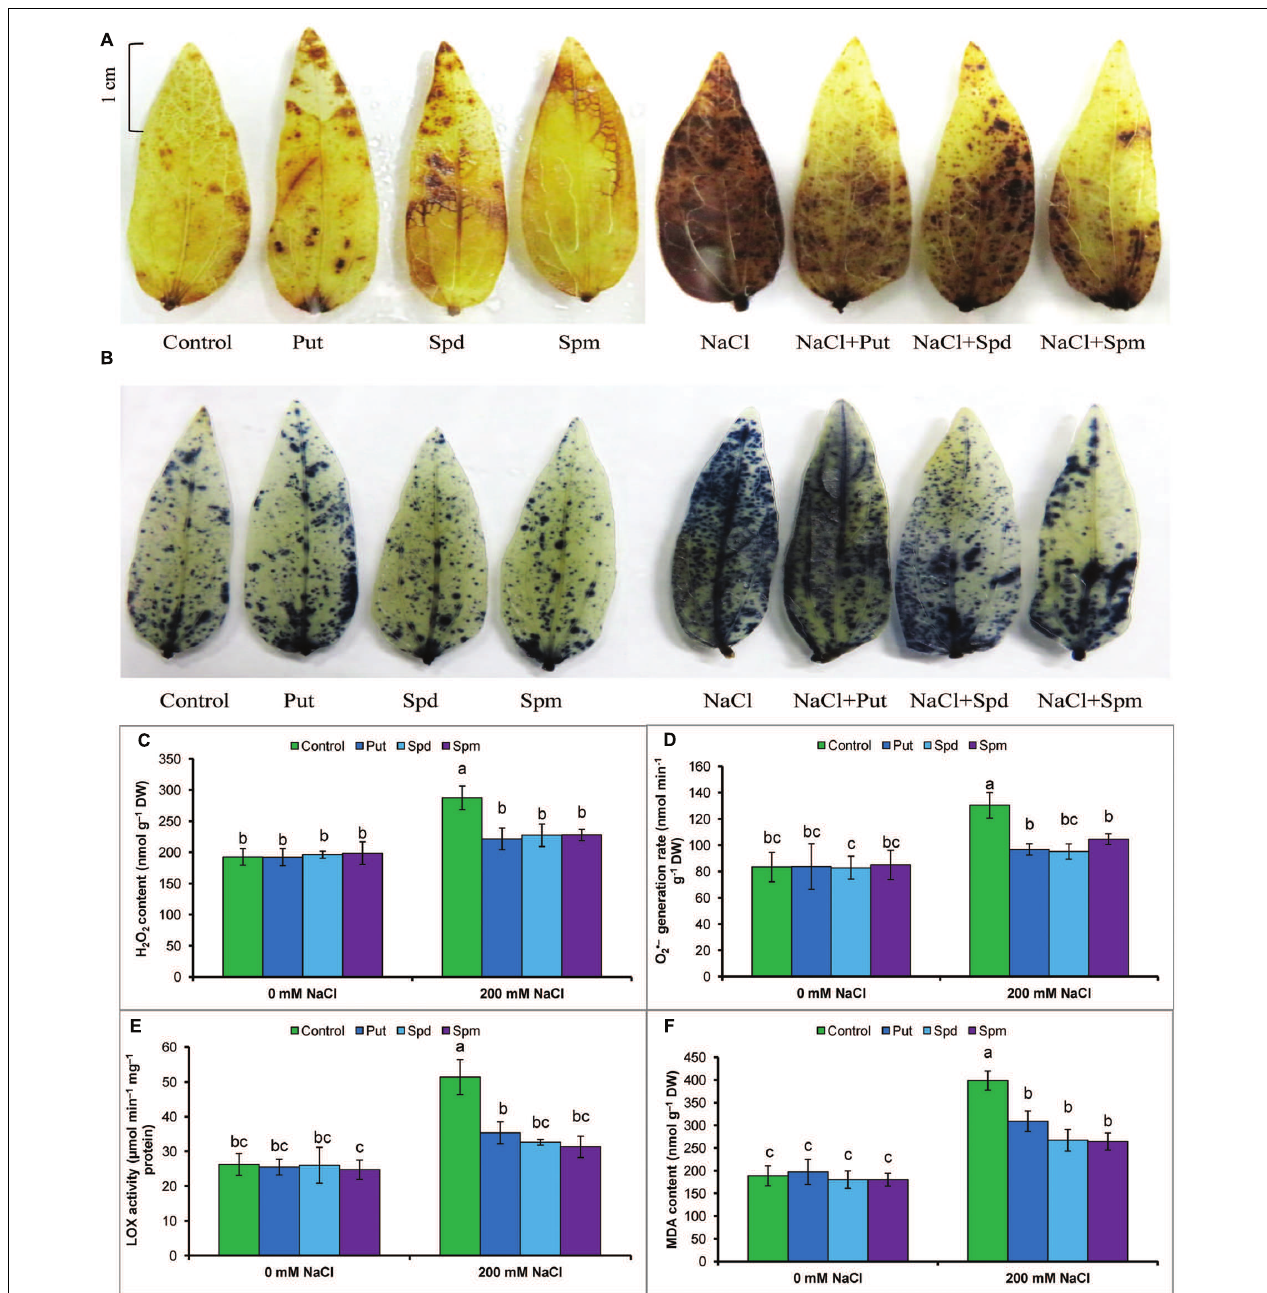
FIGURE 2 | Histochemical detection of ROS in leaves, content of ROS, LOX activity, and membrane lipid peroxidation in salt (NaCl, 200 mM) affected mung bean seedlings. DAB staining (A) of H 2 O 2 and NBT staining (B) of O •− 2 in leaves, H 2 O 2 content (C) , O •− 2 generation rate (D) , LOX activity (E) , and MDA content (F) . Here, Put, Spd, and Spm indicate putrescine (0.2 mM), spermidine (0.2 mM), and spermine (0.2 mM), respectively. Mean ( ± SD) was calculated from three replicates for each treatment. Bars with different letters are significantly different at P ≤ 0.05 applying Tukey’s HSD